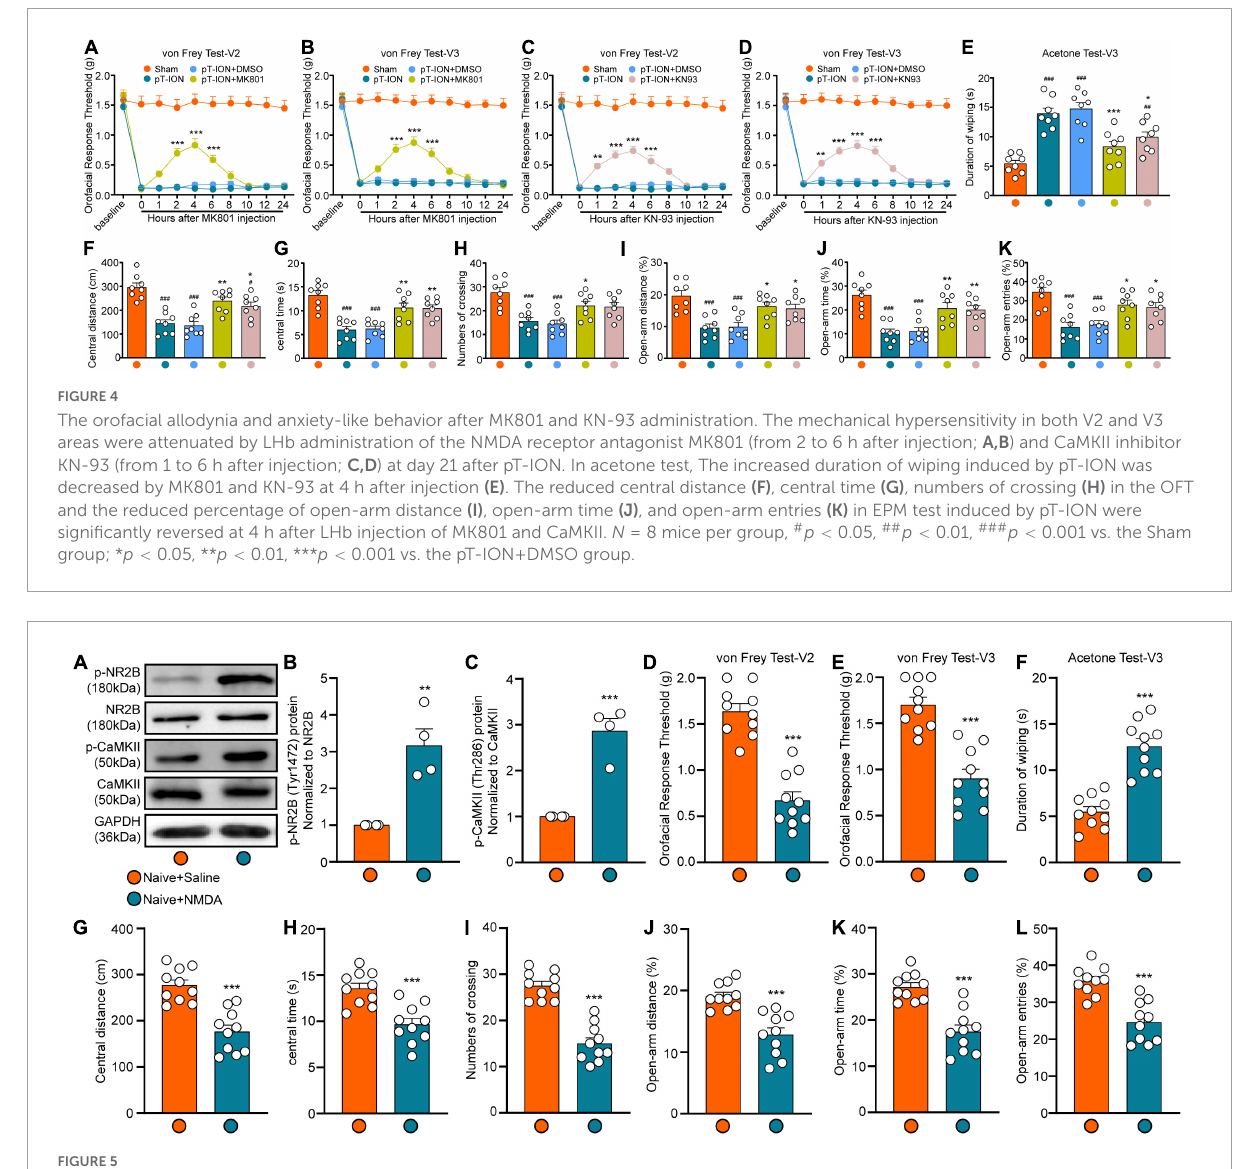
test, F = 21.67, p = 0.0004; Figures 6A–C ). The behavioral test results showed that the mechanical stimulation thresholds in V2 (one-way ANOVA and Dunnett’s test, F = 14.60, p < 0.0001, Figure 6D ) and V3 (one-way ANOVA and Dunnett’s test, F = 7.97, p = 0.0019, Figure 6E ) decreased, while the duration of wiping induced by acetone stimulation increased in V3 (one-way ANOVA and Dunnett’s test, F = 9.38, p = 0.0008, Figure 6F ) after CNO injection. Meanwhile, when compared with mice in the Naïve + HM3Dq + Saline group, those in